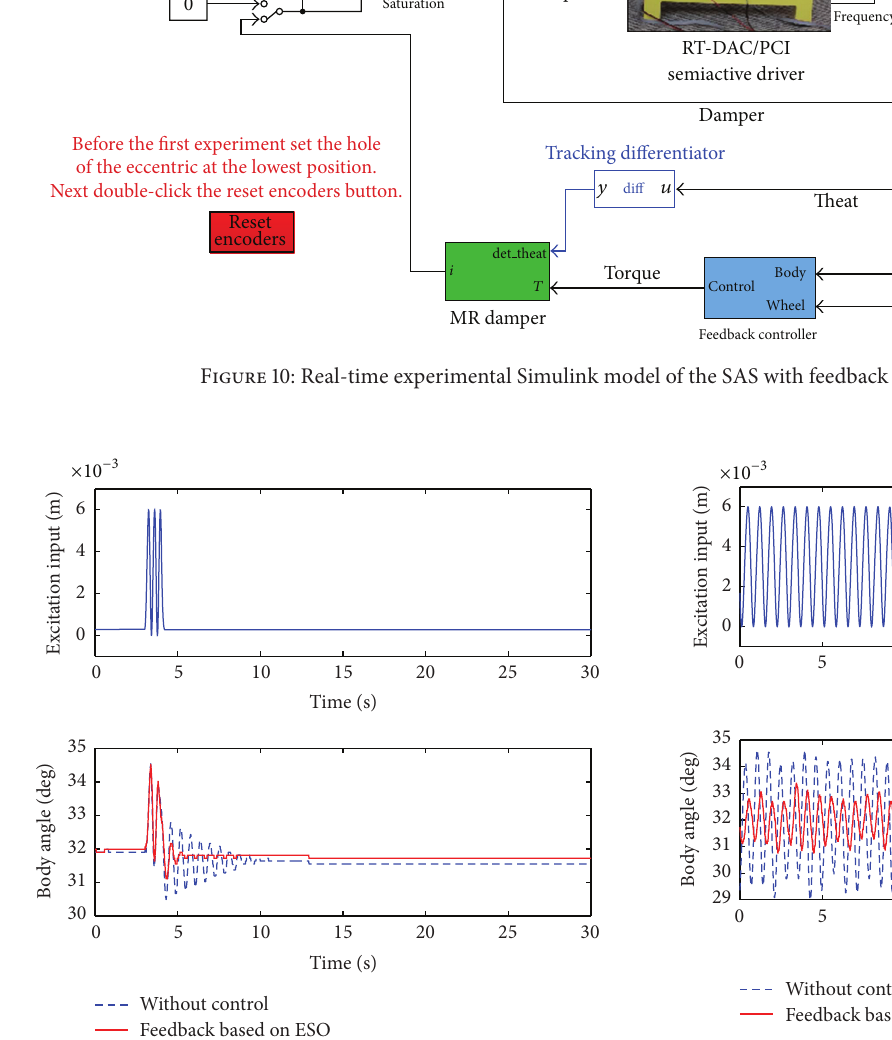
Figure 12: Continuous sinusoidal excitement input experimental